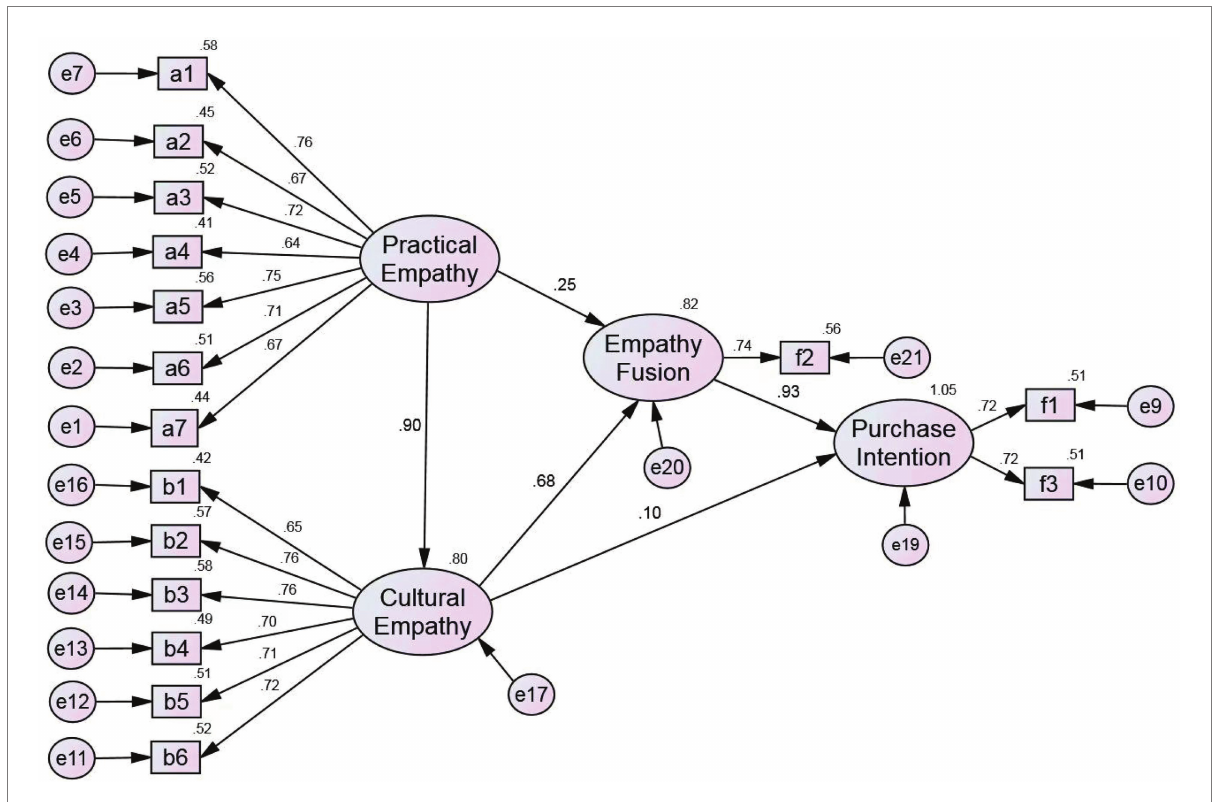
FIGURE 3 Structure